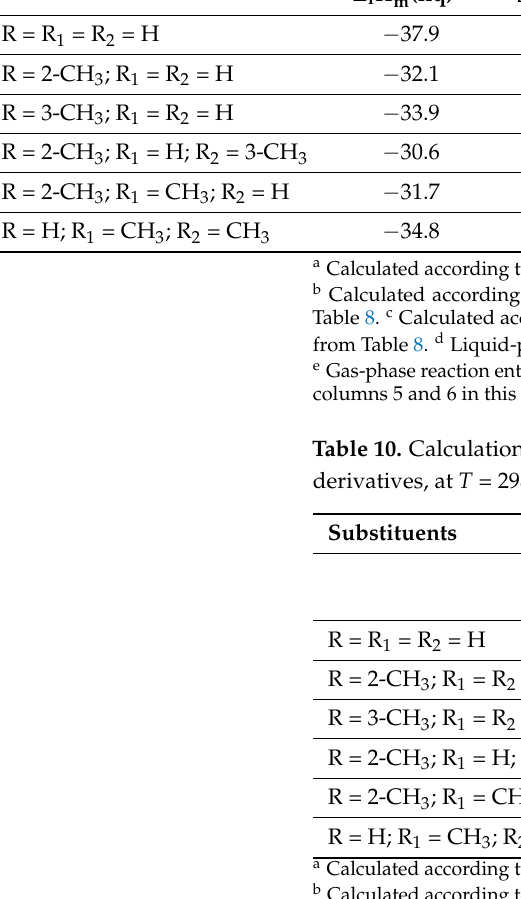
Table 8. d Reaction enthalpy per mole H 2 calculated from data for reaction